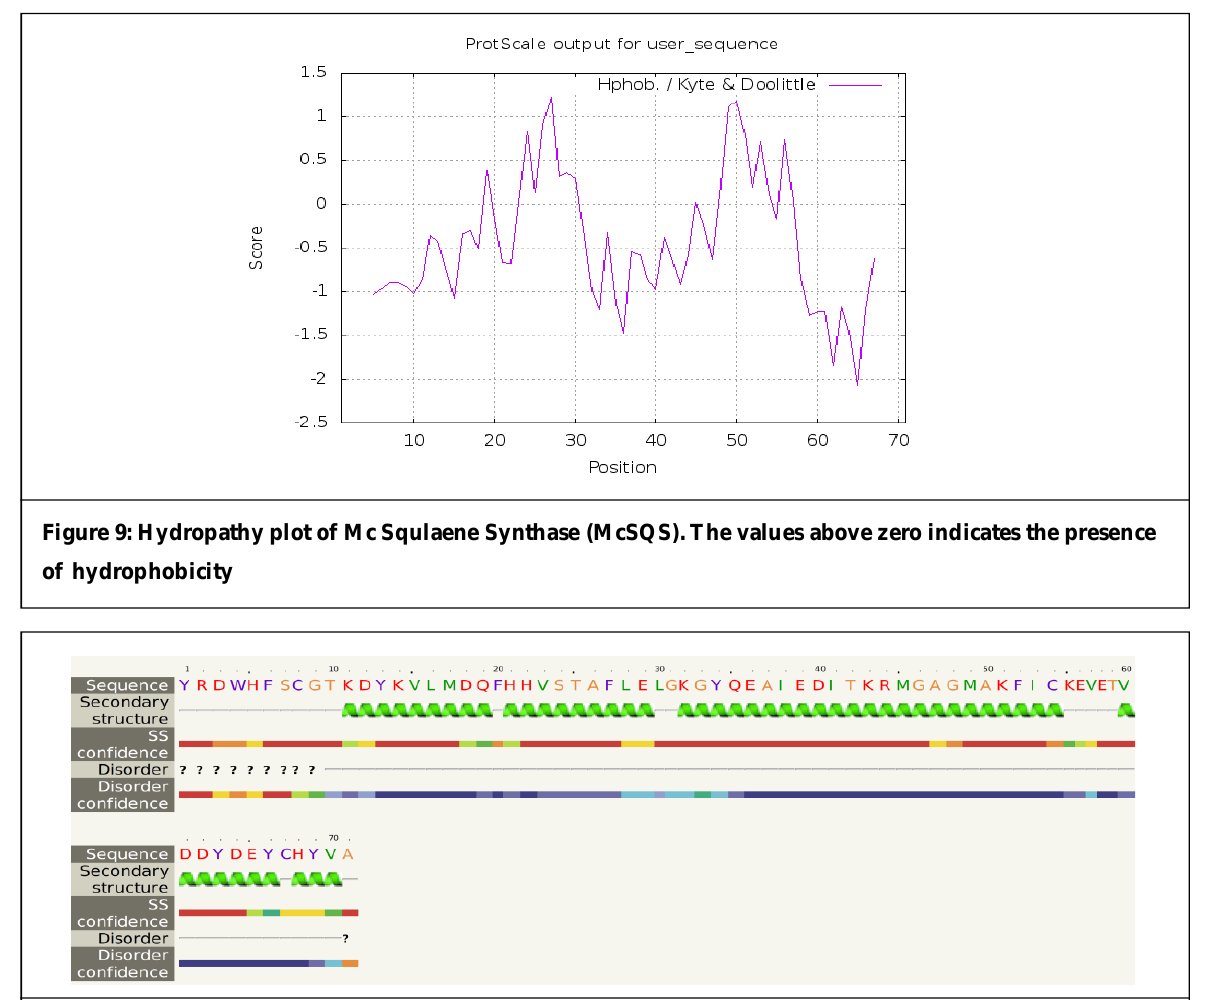
Figure 10: Domain analysis of Mc Squlaene Synthase (McSQS) by Phyre2. The red color in the SS confidence row indicates confidence to be high (9) where purple indicates low (0). In this figure 72% was found to be in alpha helix where 0% was beta